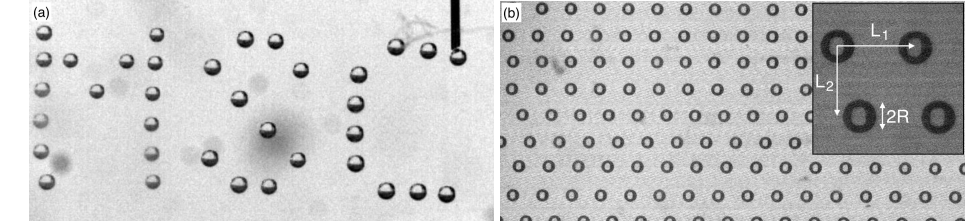
Figure 3. Two examples of bubbles injected in a yield-stress fluid. ( a ) “Bubble by bubble” injection. A capillary (see the top right part of the photo), attached to a 3D positioning system, injects bubbles in the fluid at successive pre-programmed positions. Here, the outer diameter of the capillary is 150 µ m, and the radii of the bubbles are between 120 µ m (in letter M) and 150 µ m (in letters S and C). ( b ) “Line by line” injection (sowing). The same capillary is displaced at a constant speed along horizontal lines at different heights. Here, the radius of the bubbles is R = 110 µ m ( ± 5 µ m), and the horizontal and vertical distances (see the inset) are L 1 = 527 µ m and L 2 = 465 µ m ( ± 1 µ m).